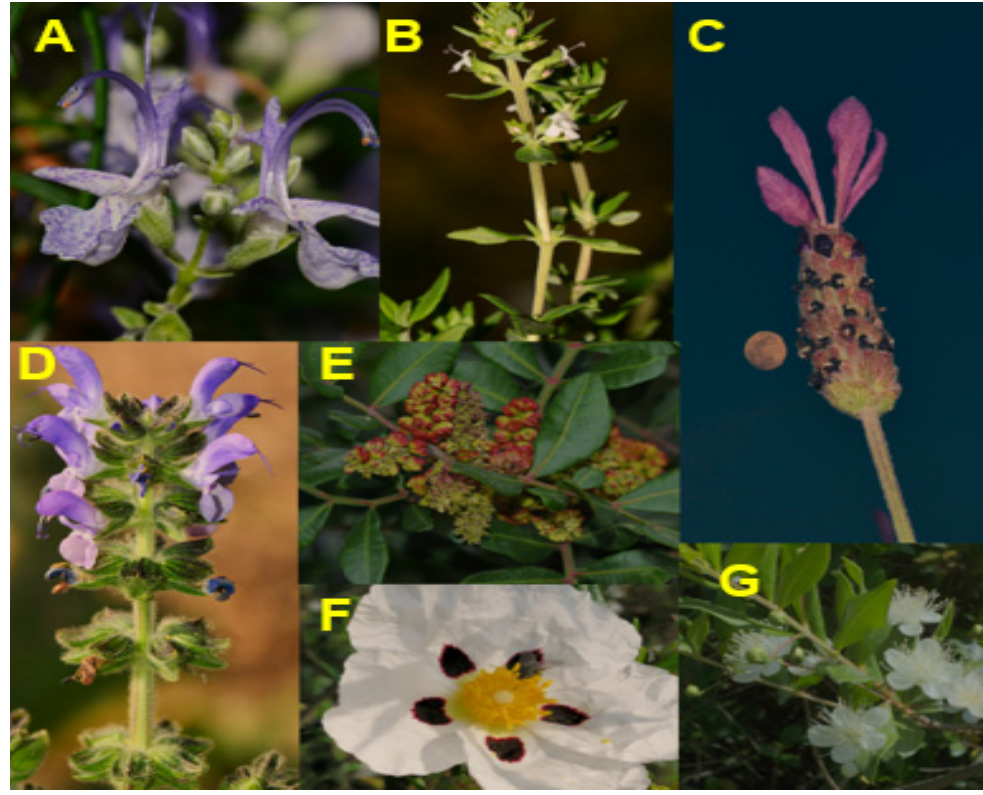
Figure 4. ( A ) Rosmarinus officinalis ; ( B ) Thymus mastichina ; ( C ) Lavandula pedunculata ; ( D ) Salvia verbenaca ; ( E ) Pistacia lentiscus ; ( F ) Cistus ladanifer ; ( G ) Myrtus communis . Photos courtesy of Dr. Rafael González-Albaladejo.